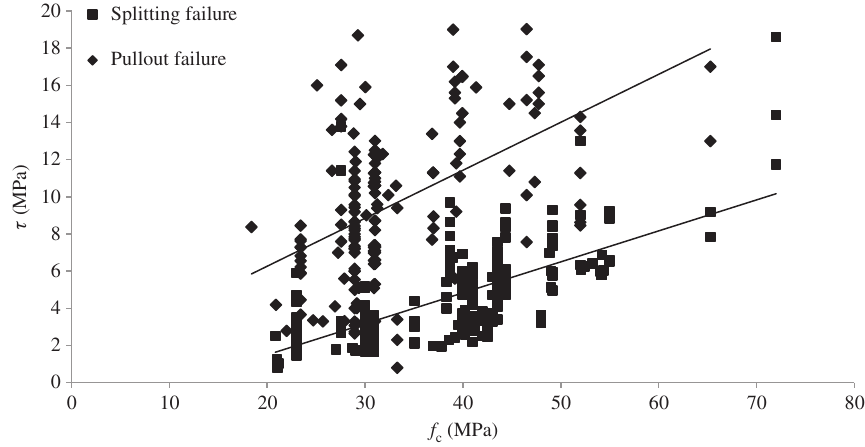
Figure 6: Bond stress of specimens against concrete strength.